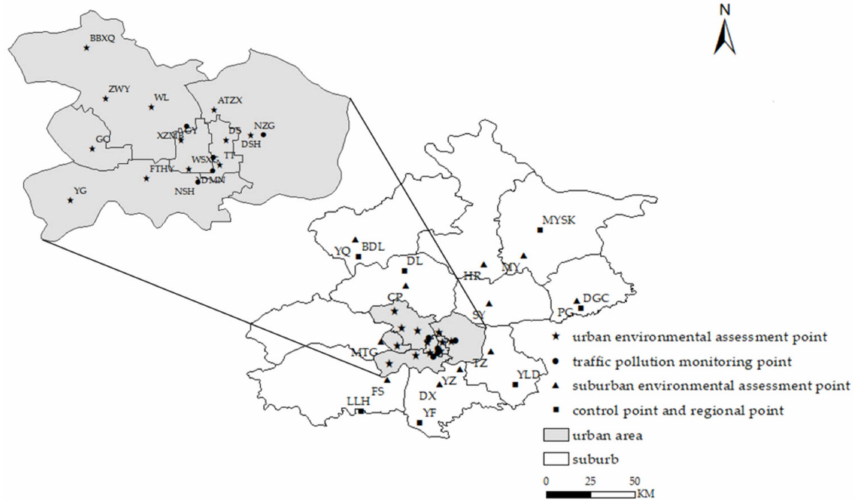
Figure 1. The distribution of PM 2.5 monitoring sites in Beijing, which is divided into urban and suburban areas and contains four types of monitoring